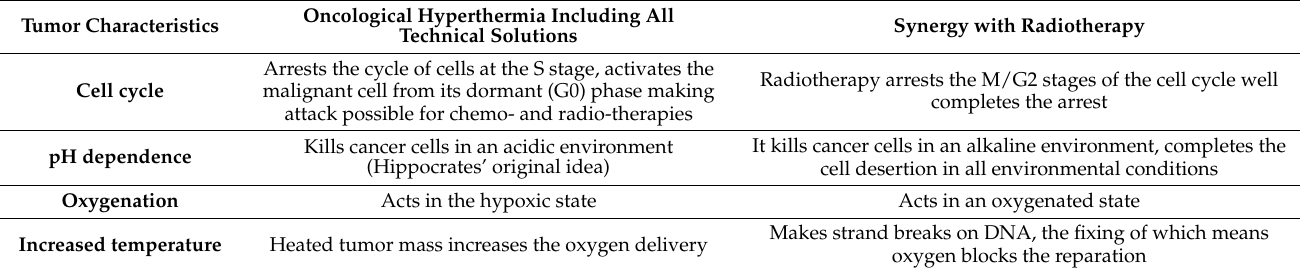
Table 1. The synergistic possibility shows a broad range of advantages for combined therapy of LRHT and RT.